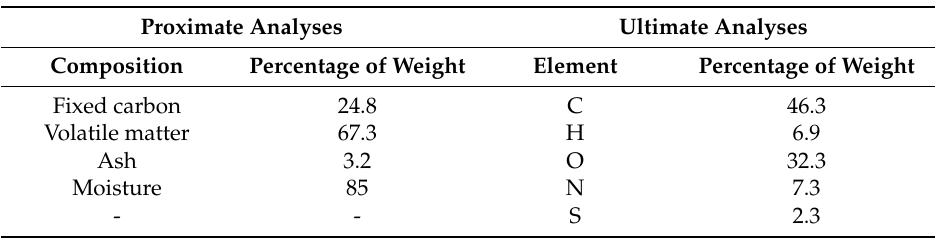
Table 1. Microalgae proximate and ultimate analyses